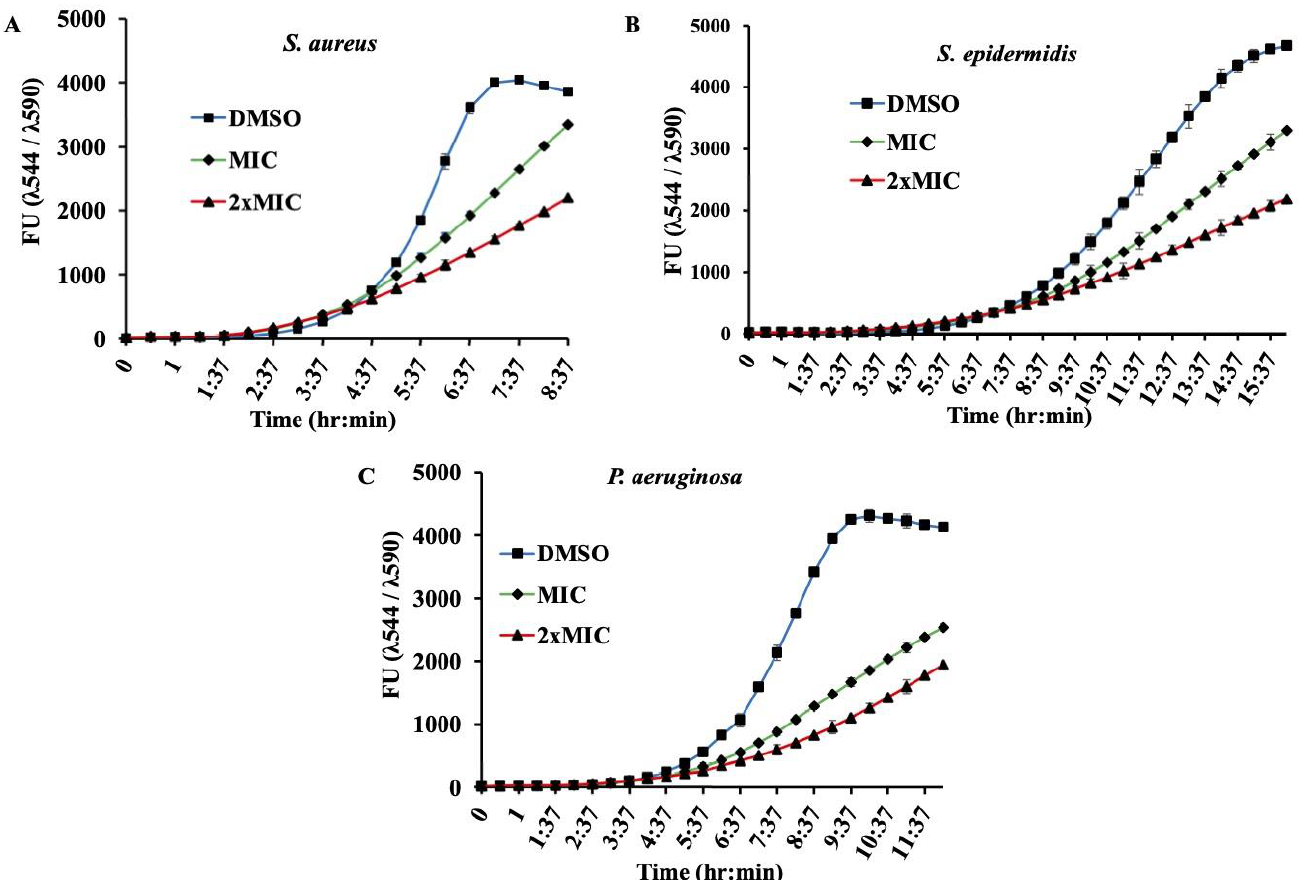
Figure 2. Growth of bacterial strains in presence of β-Lap: The growth of ( A ) S. aureus , ( B ) S. epidermidis , and ( C ) P. aeruginosa was monitored in presence of MIC and 2x MIC of β-Lap by recording fluorescence readings at 30 min intervals using alarmBlue as a growth indicator. XX’ shows time in hours and minutes.